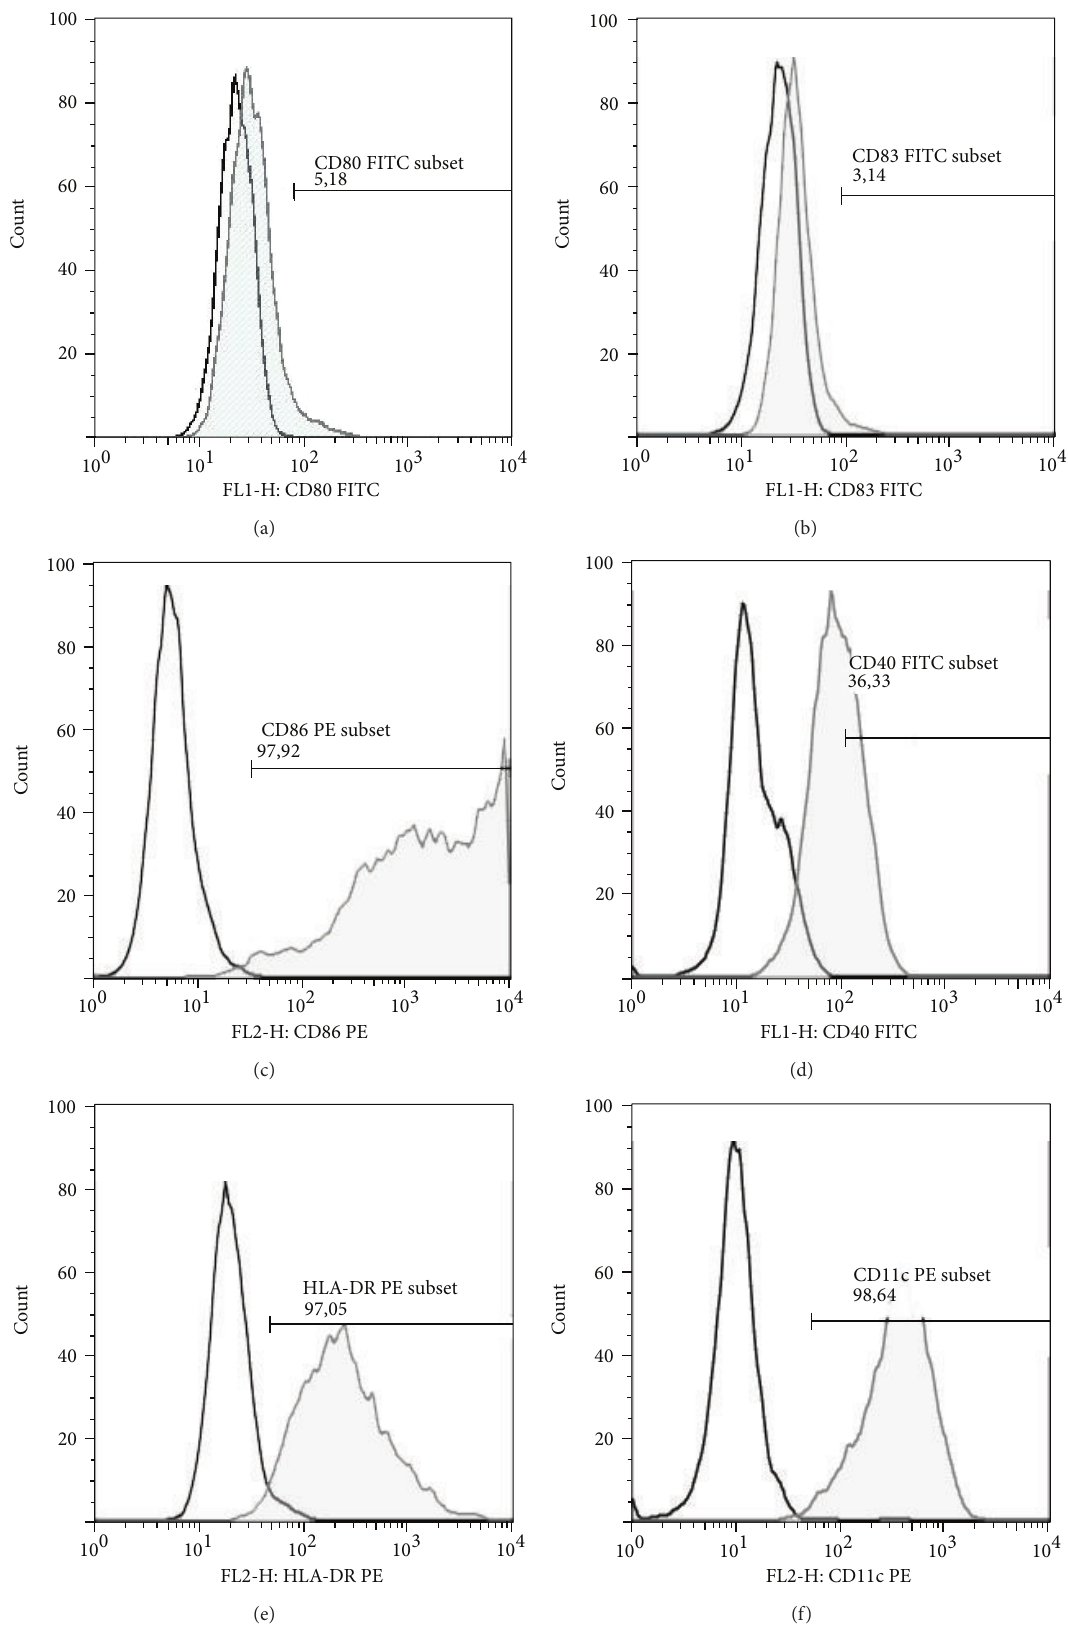
Figure1:PhenotypeofimmatureDCs.Histogramsofrepresentativecytometricdataillustratethefollowing:(a)percentageofCD80 + DCs;(b) percentage of CD83 + DCs, (c) percentage of CD86 + DCs; (d) percentage of CD40 + DCs; (e) percentage of HLA-DR + DCs; and (f) percentage of CD11c + DCs. DCs: dendritic cells; stimulated DCs are represented by filled curves; isotype controls are represented by empty